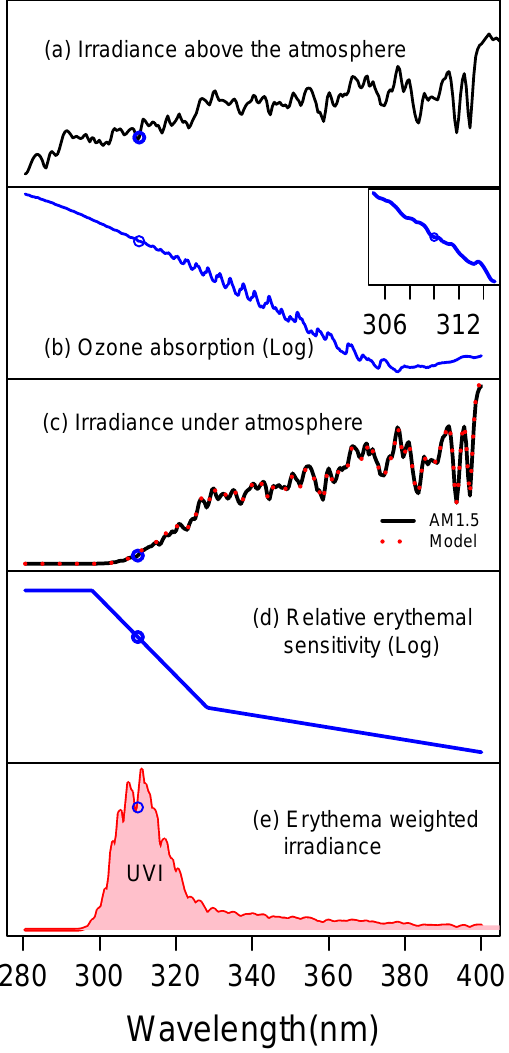
Figure 1. The solar spectrum and the wavelength dependence of its modification by the environment and contribution to the UV Index. ( a ) The AM0 solar spectrum (mW/m 2 /nm) is attenuated in